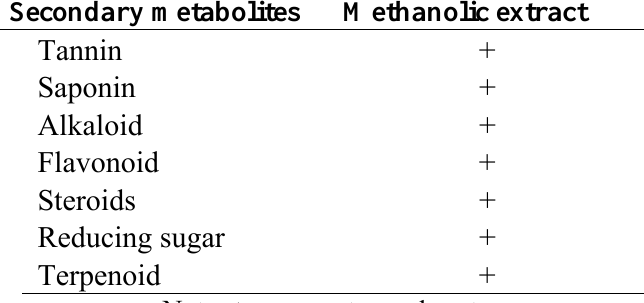
Table 1. Phytochemical Screening of Secondary Metabolites of Elaies guineensis .